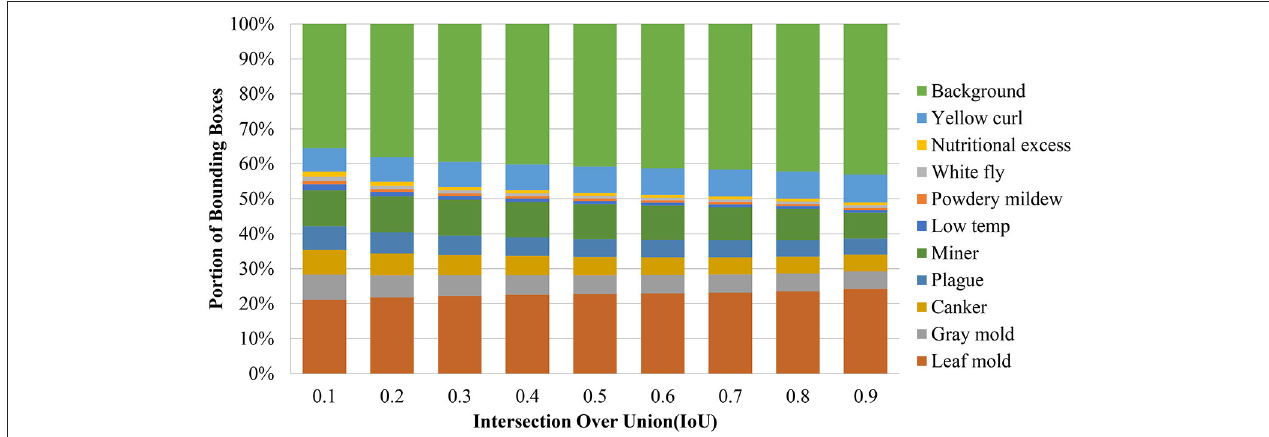
FIGURE 4 | The result of the bounding box detector evidence an unbalance between classes. Each column represents a comparison of the number of bounding boxes of each class using different intersection over union thresholds from 10 to 90%.